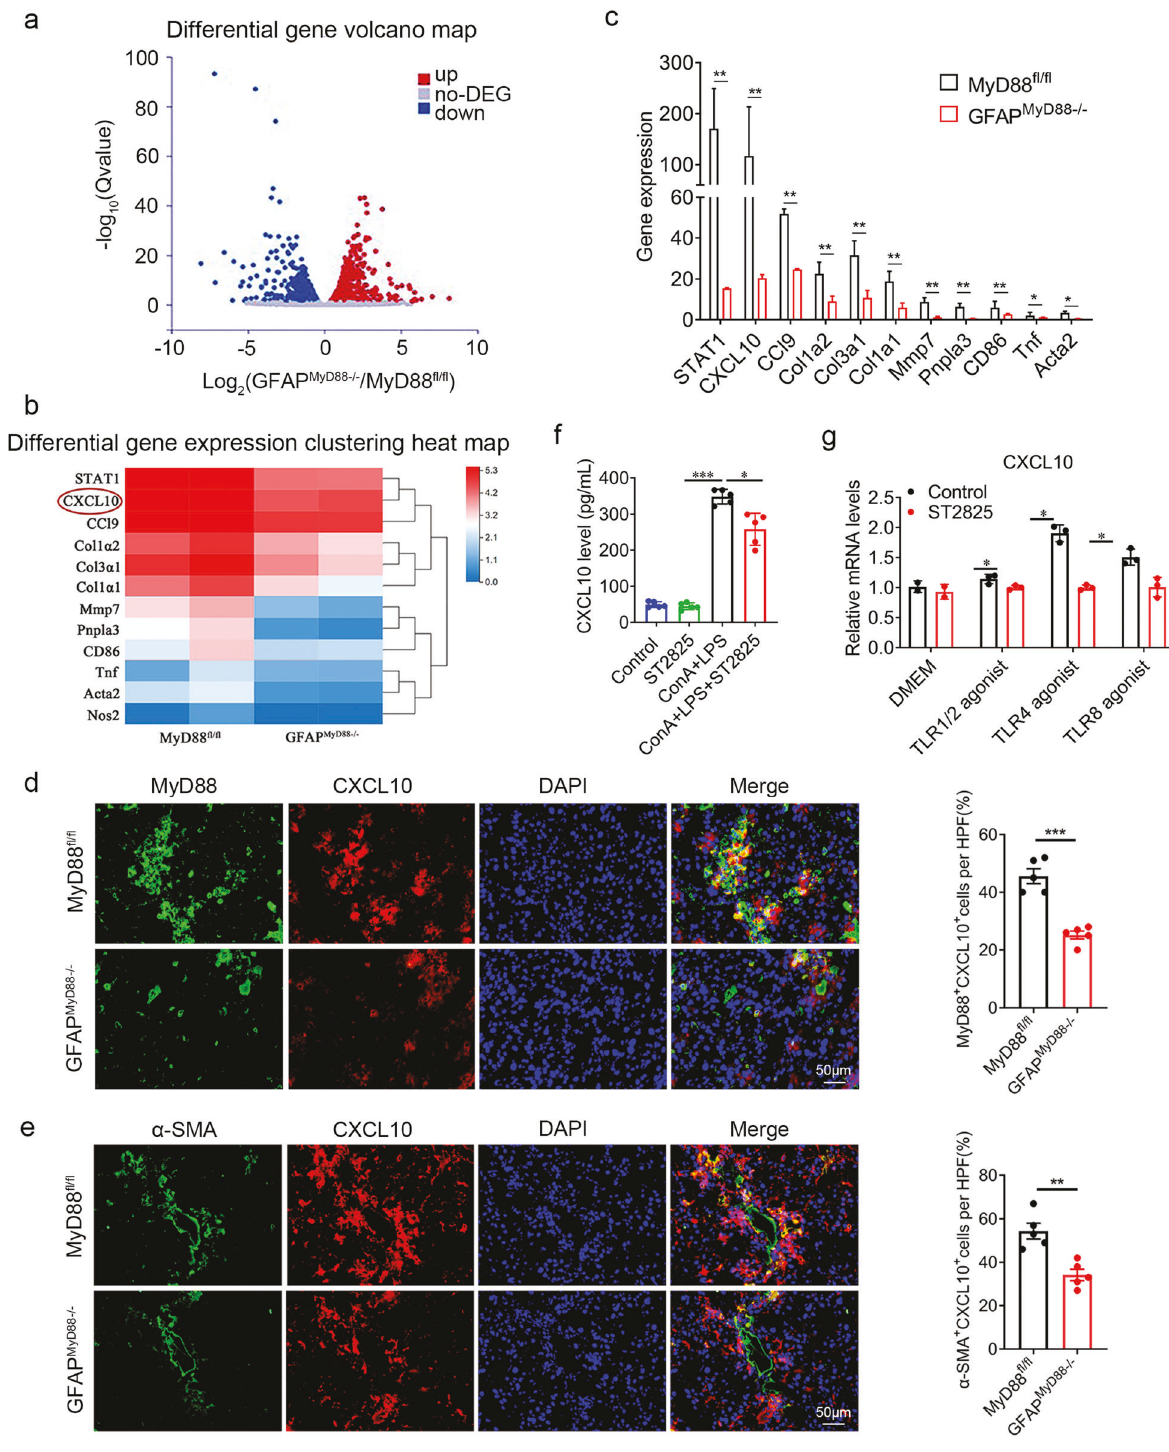
Fig. 5 Secreted CXCL10 from HSCs was critical for liver fi brosis. RNA sequencing analysis of DEGs between CCL 4 -induced liver tissues from MyD88 fl / fl and GFAP MyD88 − / − mice. a Volcano diagram of DEGs, threshold is padj < 0.05 and the absolute value of log2 Ratio ≥ 1. b Heatmap view of gene expression of fi brosis and in fl ammation related markers. c Fibrosis-related gene expression in liver tissues. d Double staining for MyD88 and CXCL10 in liver tissues (Scale bar, 50 μ m) and statistical analysis. *** p < 0.001. e Double staining for α -SMA and CXCL10 in liver tissues (Scale bar, 50 μ m). ** p < 0.01. f The secretory protein levels of CXCL10 in LPS, ConA and inhibitor ST2825 treated LX-2 medium were measured using ELISA. * p < 0.05, *** p < 0.001; g Inhibited MyD88 in LX-2 cells were treated with Inhibitor ST2825 (Scale bar, 20 μ M), and agonists of TLR1/2, TLR4, TLR8 for 24 h. CXCL10 expression in LX-2 cells was detected by qPCR. ** p < 0.01. These charts show the average of the experimental results, with the error bar showing the standard error of mean.